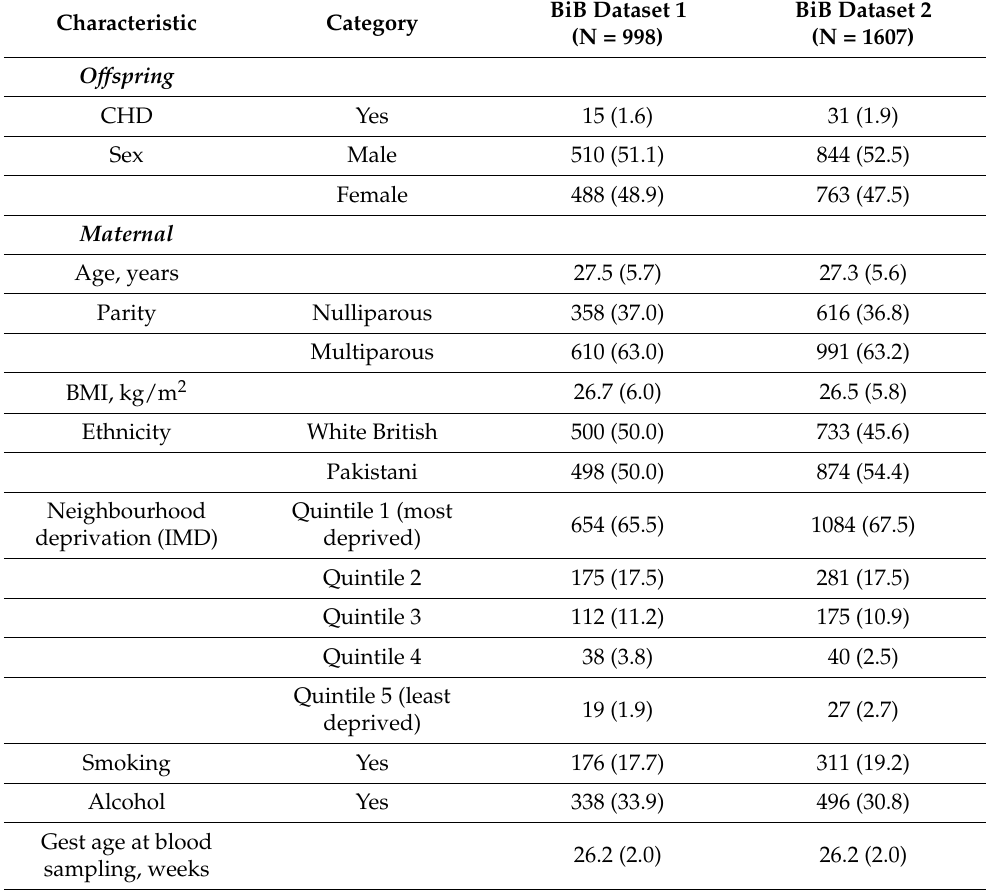
Table 1. Participant characteristics for the Born in Bradford metabolomic